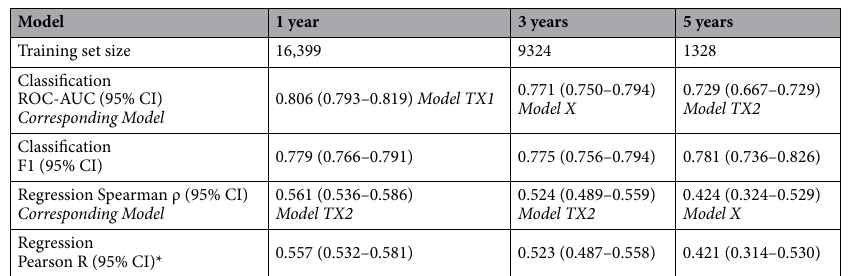
Table 2. Performance summary for best models on 1, 3, 5-year(s) expenditure. CI confidence interval. *Pearson R is calculated using log 10 -transformed data.